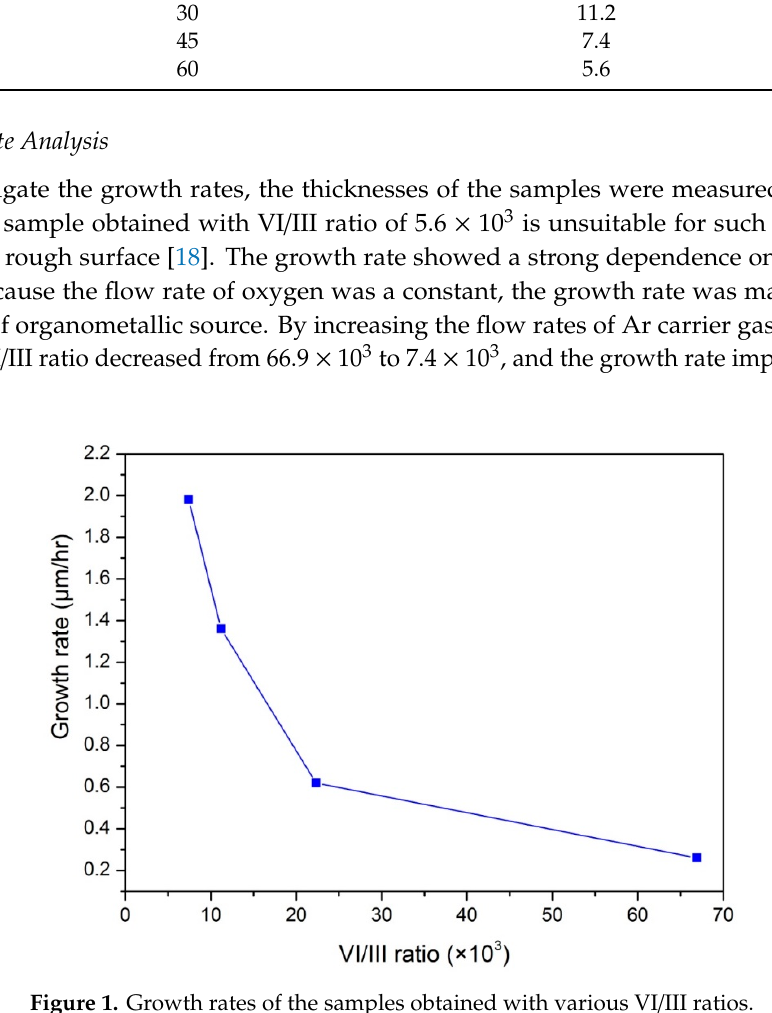
Figure 1. Growth rates of the samples obtained with various VI/III ratios.